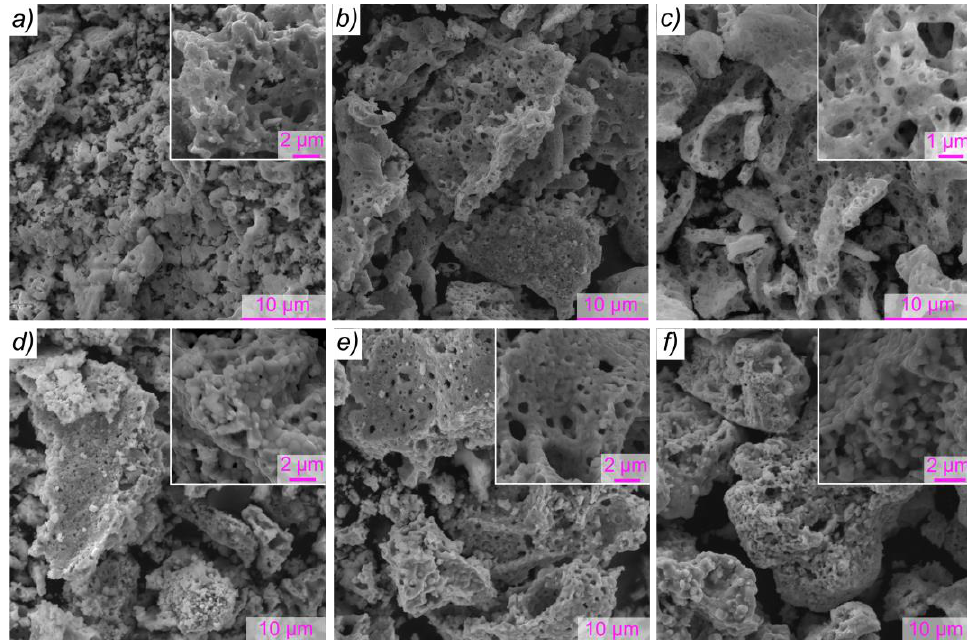
Figure 5. SEM images of the SCS products obtained using different fuels and additives (the upper- right inset shows the corresponding high magnification image): ( a ) glycine, φ = 1.4; ( b ) glycine and NH 4 NO 3 , φ = 1.25; ( c ) glycine and glucose, φ = 1.4; ( d ) urea, φ = 3.5; ( e ) urea and NH 4 NO 3 , φ = 2.9; ( f ) urotropine, φ = 2.